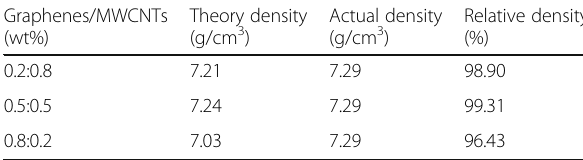
Table 3 Relative densities of nanocomposite